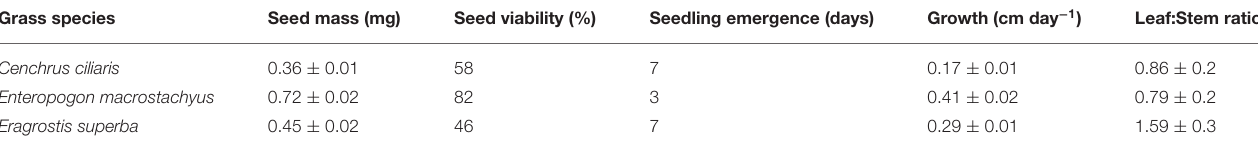
TABLE 1 | Selected characteristics of perennial African rangeland grasses used for ecological restoration. Grass species Seed mass (mg) Seed viability (%) Seedling emergence (days) Growth (cm day − 1 ) Leaf:Stem